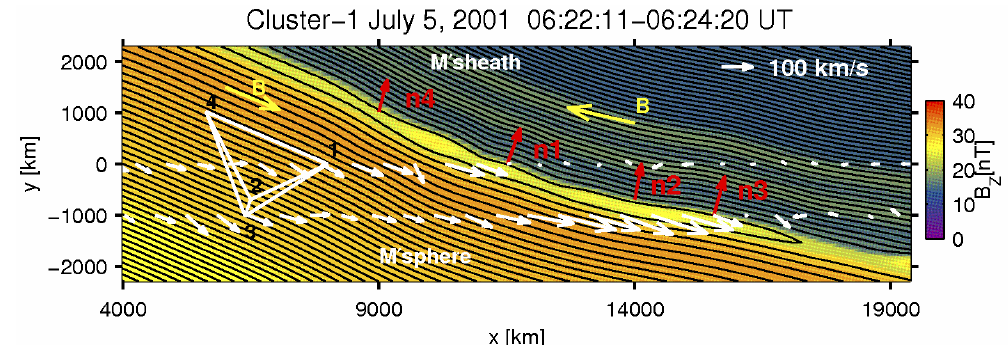
Fig. 3. Portion of magnetic field map from magneto-hydrostatic Grad-Shafranov reconstruction, based on C1 data taken during the mag- netopause crossing on 5 July 2001. The white vectors are plasma velocities in the HT frame, projected onto the reconstruction plane. The red arrows are the normal vectors from MVAB0. The white constellation denotes the projected location of the four Cluster spacecraft on the map. Magnetosphere (magnetosheath) is in lower left (upper right) of the map; sunward/northward is to the right. For a more detailed description, see Hasegawa et al.